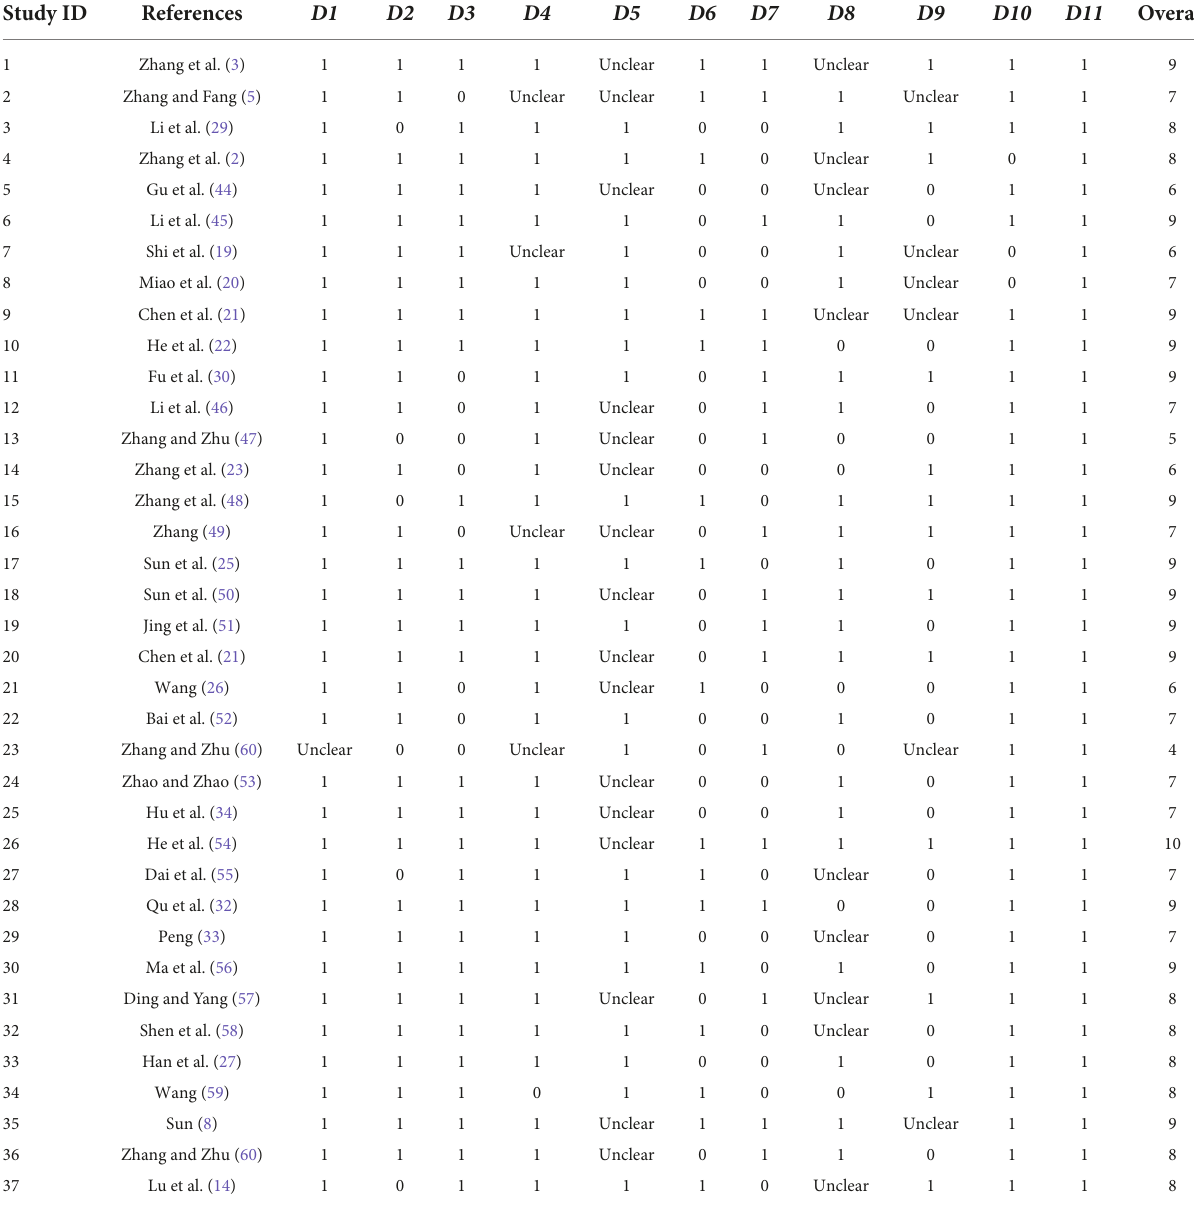
TABLE 2 Quality evaluation results of systematic review of Chinese village doctors’ job satisfaction.